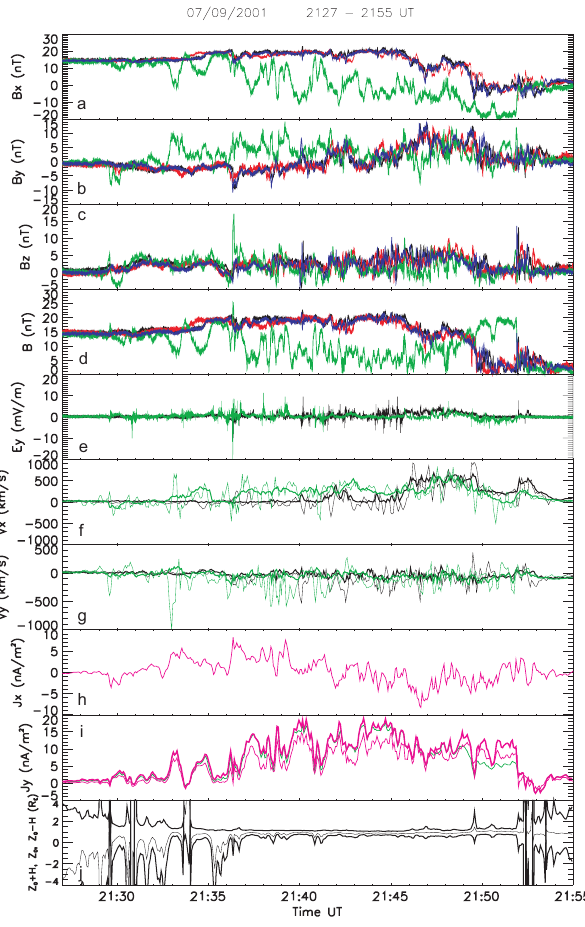
Fig. 11. Crossing of an active CS (September 7, 2001). From top to bottom, high time resolution data from FGM ( B x , B y , B z , B ) and EFW ( E y ). Unless otherwise noted, black is for S/C 1, red for S/C 2, green for S/C 3 and blue for S/C 4. V xi from CIS (thick line) and V xe from PEACE (thin line) on S/C 1 and S/C 3, same for V y ,. J x and J y (thin pink line), computed from curlB, equatorial current density (thick pink line) and at the location of S/C 3 (thick green line) from Harris model (thin pink line), with B L =25nT (see text for more